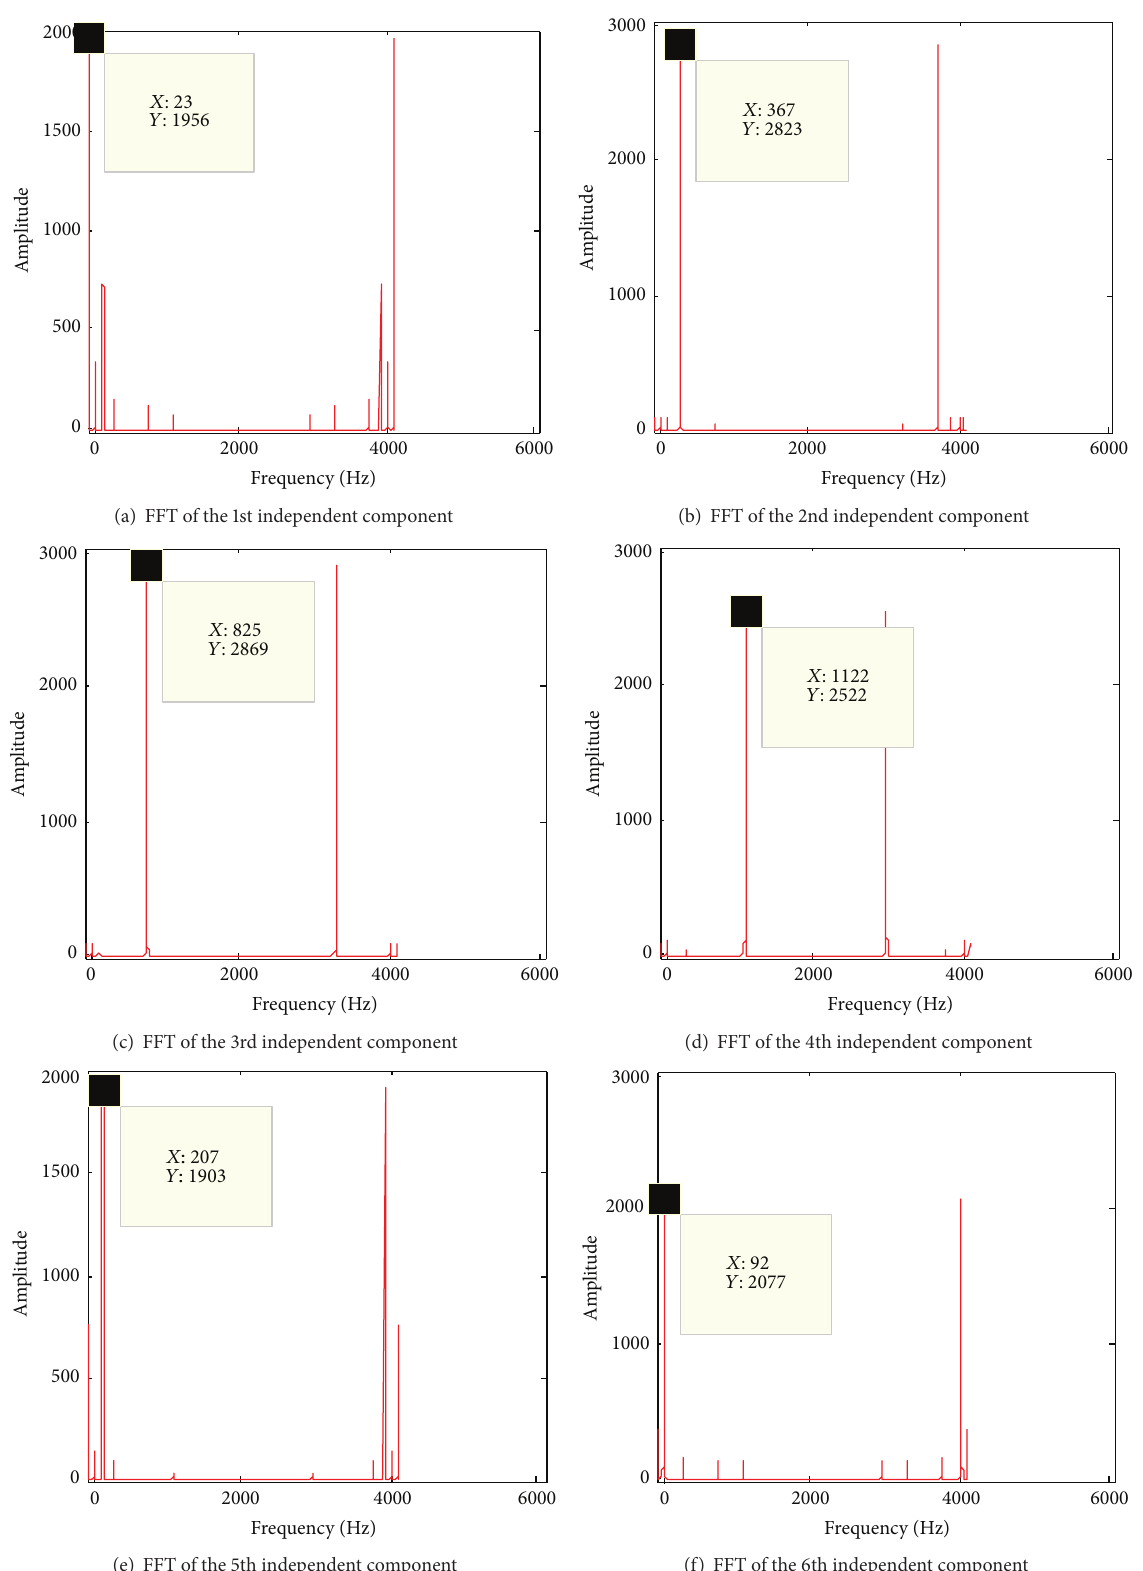
Figure 11: FFT of each independent component identified by Infomax with gradient descent